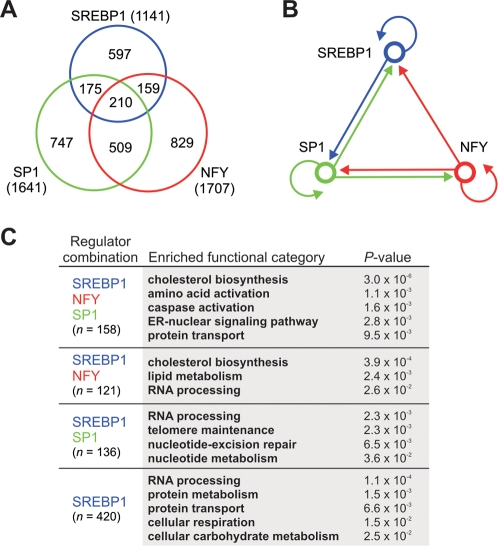
Genome-wide co-occupancy of SREBP1 with network partners NFY and SP1.A) Venn diagram showing the overlap among the sets of SREBP1-, NFY-, and SP1-occupied genes. B) Network diagram of the regulatory interactions observed among SREBP1, NFY, and SP1. Arrows indicate direct binding of one regulator to the promoter of another regulator or to its own promoter. Arrows to SREBP1 were determined by ChIP-qPCR with primers for the SREBP1c promoter as this promoter was not represented on the promoter array. C) Combinatorial regulation of SREBP1 target genes. Enriched GO categories were identified in each set of SREBP1 target genes occupied by a distinct combination of factors (or by SREBP1 alone) using BiNGO [18]. The number of genes with GO annotation within each set is indicated in parentheses. Representative enriched GO categories and their P-values are displayed for each regulator combination; the entire set of enriched GO categories for each combination is listed in Table S9.